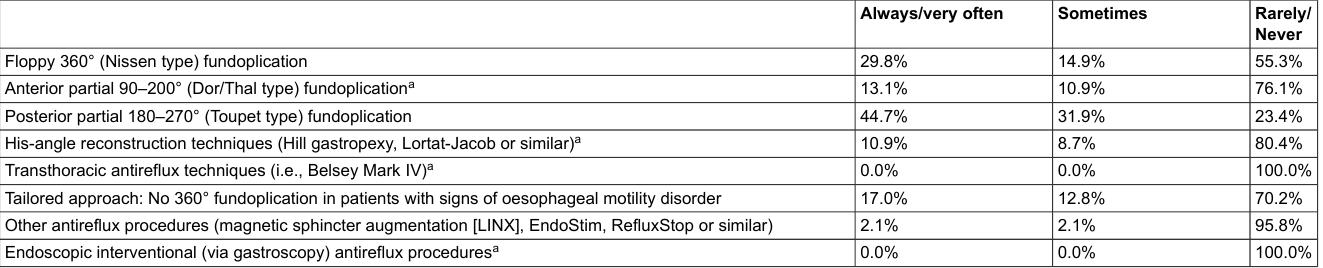
Table 6: Antireflux